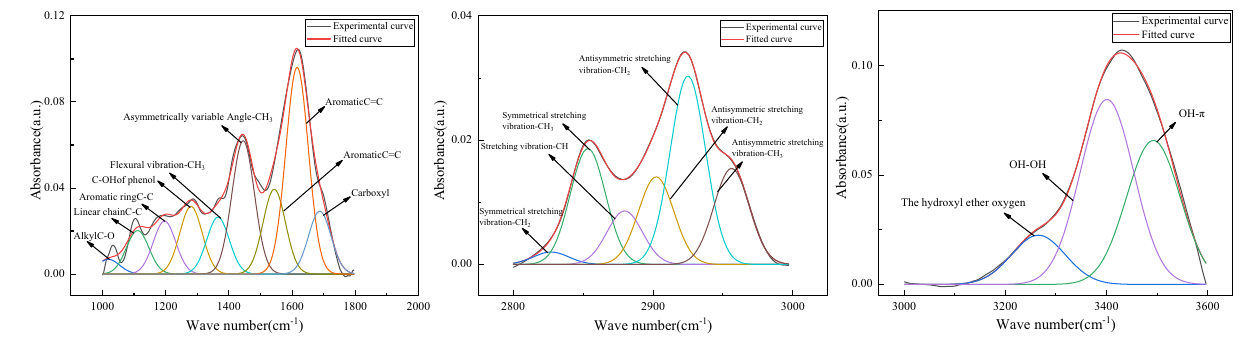
Figure 4. Multimodal fit curves of coals treated without antioxidants in the 3650–3000, 3000–2800 and 1800–1000 cm −1 regions.